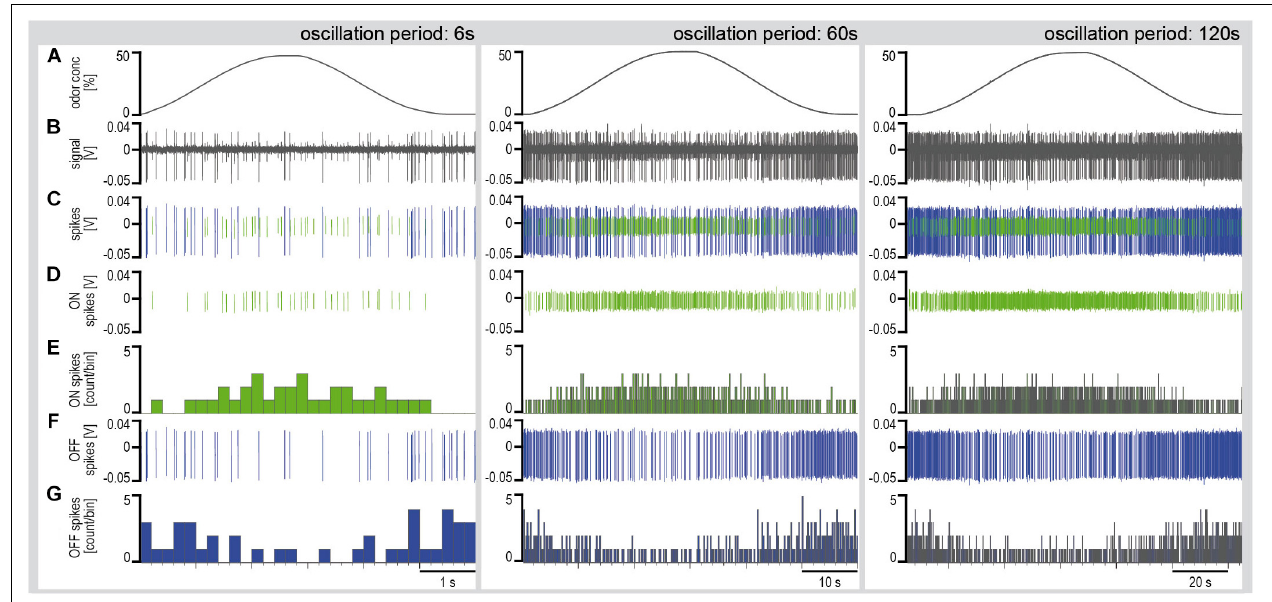
FIGURE 4 | Simultaneously recorded single sensillum responses of a pair of ON and OFF ORNs to oscillating concentration changes of the lemon oil odorant with periods of 6, 60, and 120 s. Air flow velocity: 1.69 m/s. (A) Time course of instantaneous odorant concentration. (B) Electrical activity of the ON and OFF ORNs. Both types discharge continuously during the concentration cycles. The large impulse amplitudes are from the OFF ORN. (C) Off-line sorted action potentials of the ORNs obtained by spike detecting and template matching techniques using Spike2 software (Cambridge Electronic Design, United Kingdom). Green impulses are from the ON ORN, blue impulses from the OFF ORN. (D) Discriminated impulses of the ON ORN. (E) Instantaneous impulse frequency of the ON ORNs; bin width, 0.2 s. (F) Discriminated impulses of the OFF ORN. (G) Instantaneous impulse frequency of the OFF ORNs; bin width, 0.2 s. F impulse frequency, V voltage.